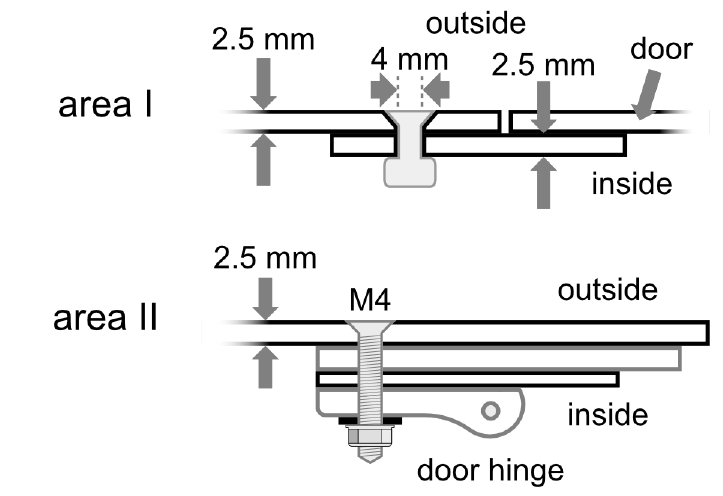
Figure 4. A sketch of the cross section of area I and